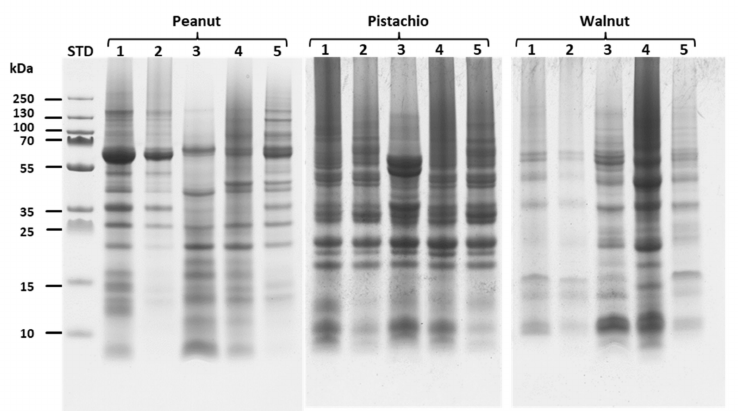
Figure 2. SDS PAGE band profiles of the extracted proteins of peanut, pistachio and walnut. Lines 1, 2, 3, 4 and 5 of the SDS PAGE pictures represent samples from ambi/urea, CM/NaCl, PVPP, SDS and TCA extraction methods,